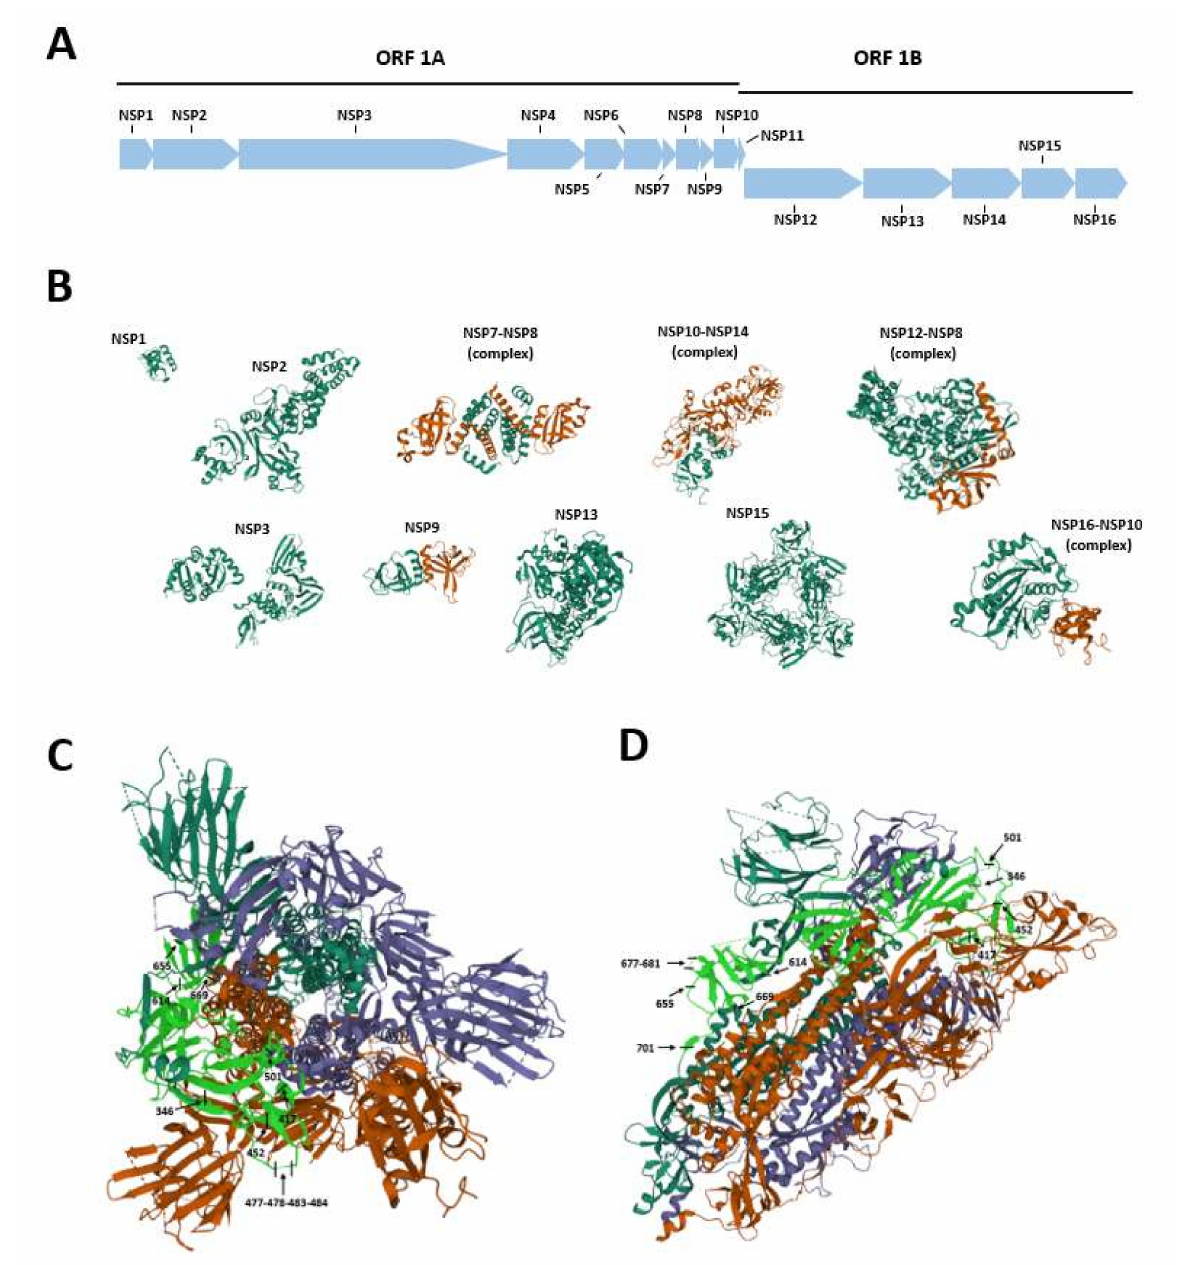
Figure 1. Known structures for SARS-CoV-2 proteins and mutation position of SARS-CoV-2 spike protein. ( A ) Schematic representation of genomic organization of SARS-CoV-2. ( B ) When available, the three-dimensional (3D) structure models were obtained from Protein Data Bank (PDB) database (https://www.rcsb.org/, accessed 11 August 2021). A cartoon representation for each available protein and/or protein complexes is shown. ( C , D ) Structural domain and mutation position of SARS-CoV-2 spike protein. The 3D structure of SARS-CoV-2 spike protein (6VYB, RCSB Protein Data Bank) is shown in up ( C ) and down ( D ) conformations. SARS-CoV-2 spike regions carrying mutations are RDB and SD1-2_S1-S2_S2 regions (labeled in green). ( C ) R346K, K417T, K417N, L452R, N501Y, D614G, H655Y, and G669S mutations are shown in the up conformation, while A701V mutation is not observable with this protein orientation. ( D ) R346K, K417T, K417N, L452R, N501Y, D614G, H655Y, G669S, and A701V mutations are observable in the down conformation. Due to protein orientation reasons, the localization of S477N, T478K, V483A, E484K, E484Q, Q677H, P681H, and P681R mutations is not visible with both up and down